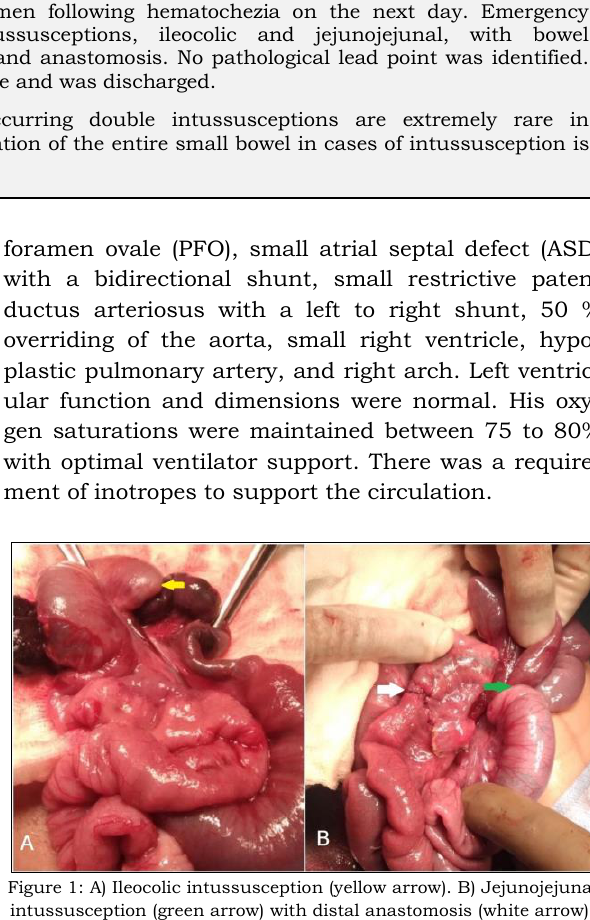
abdominal distension, bilious aspirate, and an